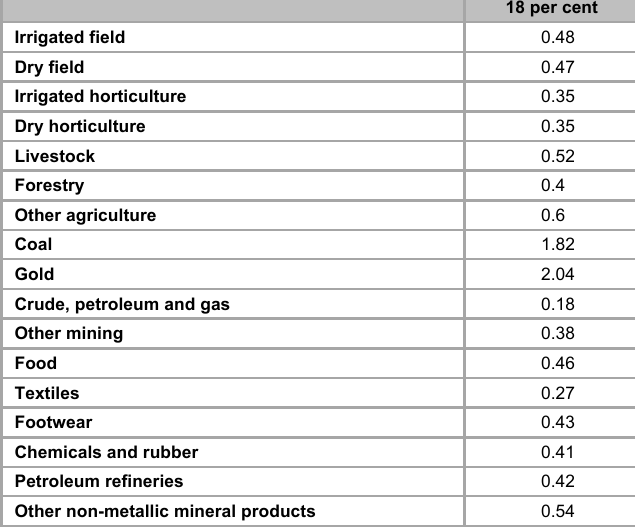
Short-run employment changes by